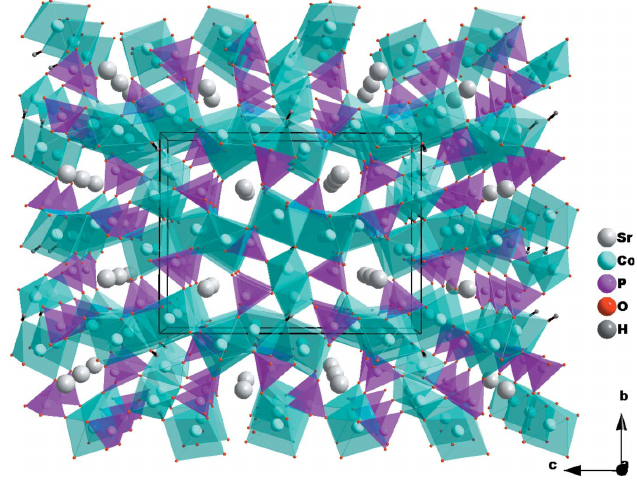
Figure 5 The crystal structure of SrCo 4 (OH)(PO 4 ) 3 in a projection along [100], showing channels in which the strontium cations are located.